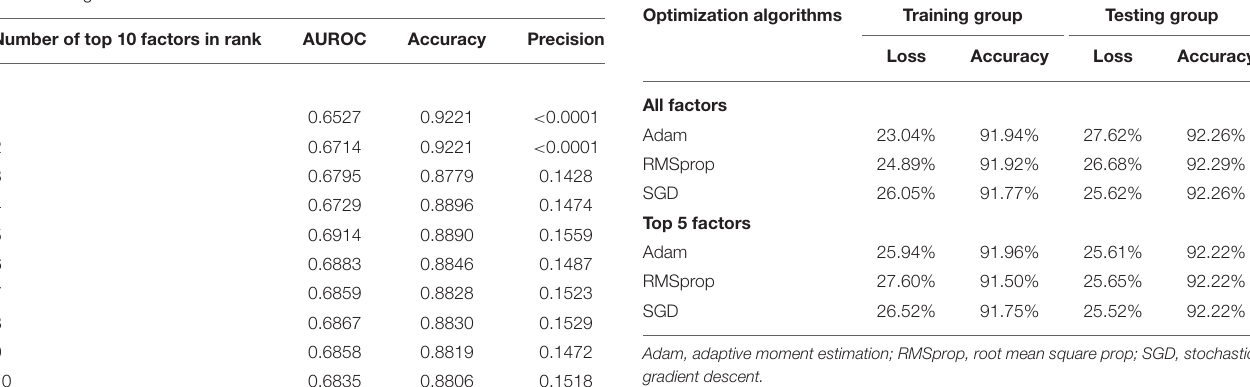
TABLE 3 | Distributions of areas under the receiver operating curve (AUROC), accuracy and precision with the cumulating number of top 10 important factors in an ascending order.